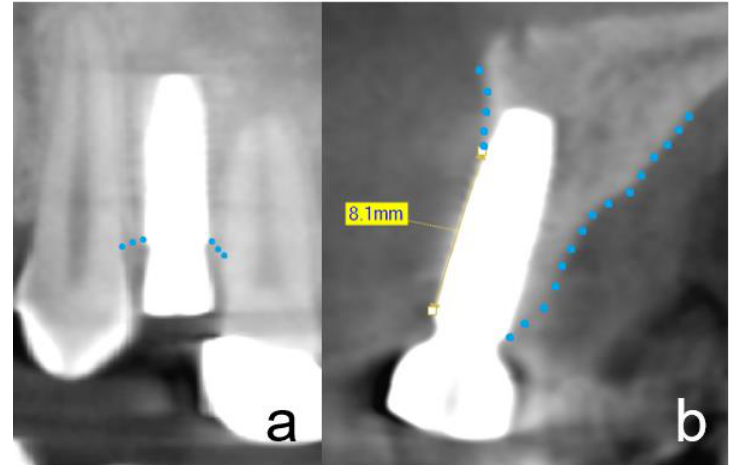
Figure 3. CBCTs after implant exposure. Dotted lines trace the outline of the alveolar ridge. ( a ) No horizontal bone loss at the mesial and distal implant shoulder is detectable at the time of implant exposure. ( b ) Measurement at the time of implant exposure from the implant shoulder to the first implant/hard tissue bone contact. In this case, 8.1 mm of the buccal lamella bone was completely resorbed.